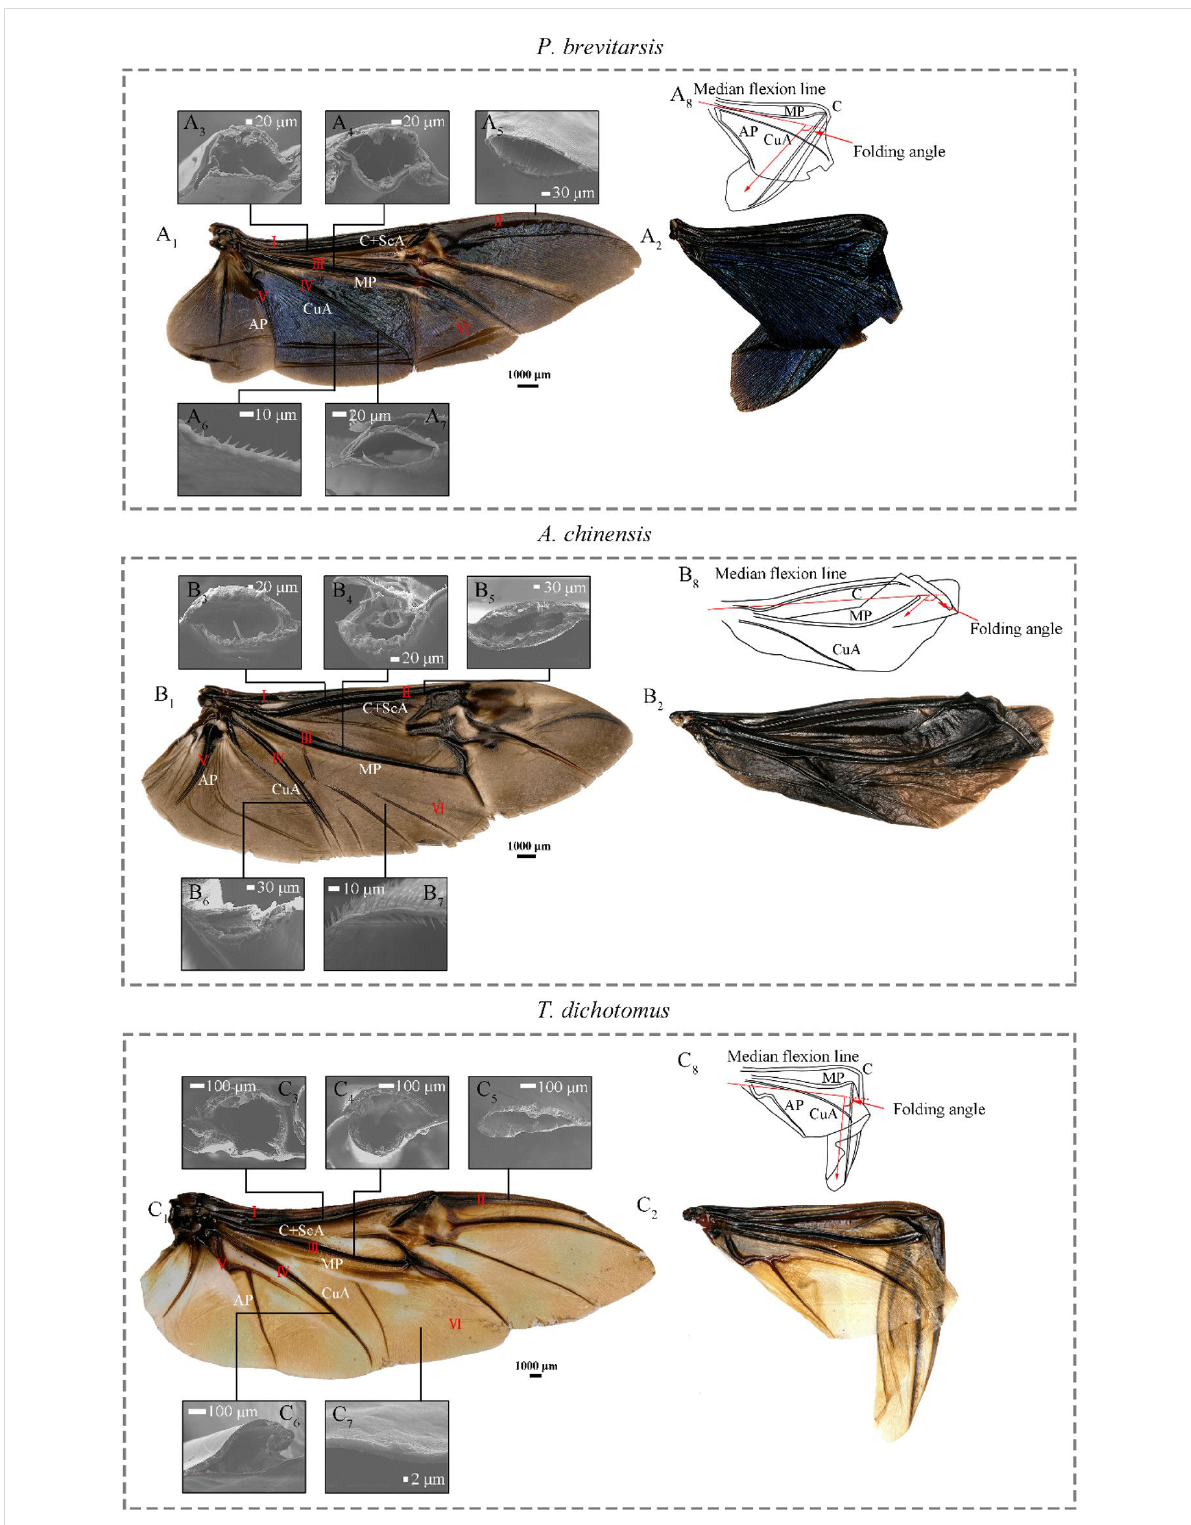
Figure 3: (A), (B), and (C) show hind wings of P. brevitarsis , A. chinensis , and T. dichotomus , respectively. (A 1 ) and (A 2 ), (B 1 ) and (B 2 ), and (C 1 ) and C 2 show the extended and folded hind wings of P. brevitarsis , A. chinensis , and T. dichotomus , respectively. (A 3 –A 7 ), (B 3 –B 7 ), and (C 3 –C 7 ) show cross-sectional morphologies of costal “C”, media posterior “MP”, the posterior end of “C”, wing membrane, and anal posterior “AP” of the three beetles,